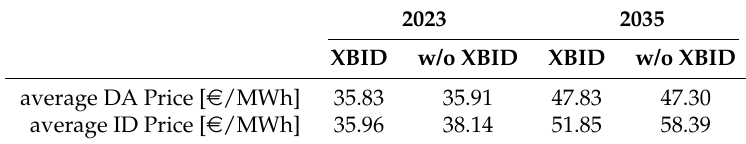
Table 2. Average price of DA and ID with and without ID CB trading (XBID) in Germany.